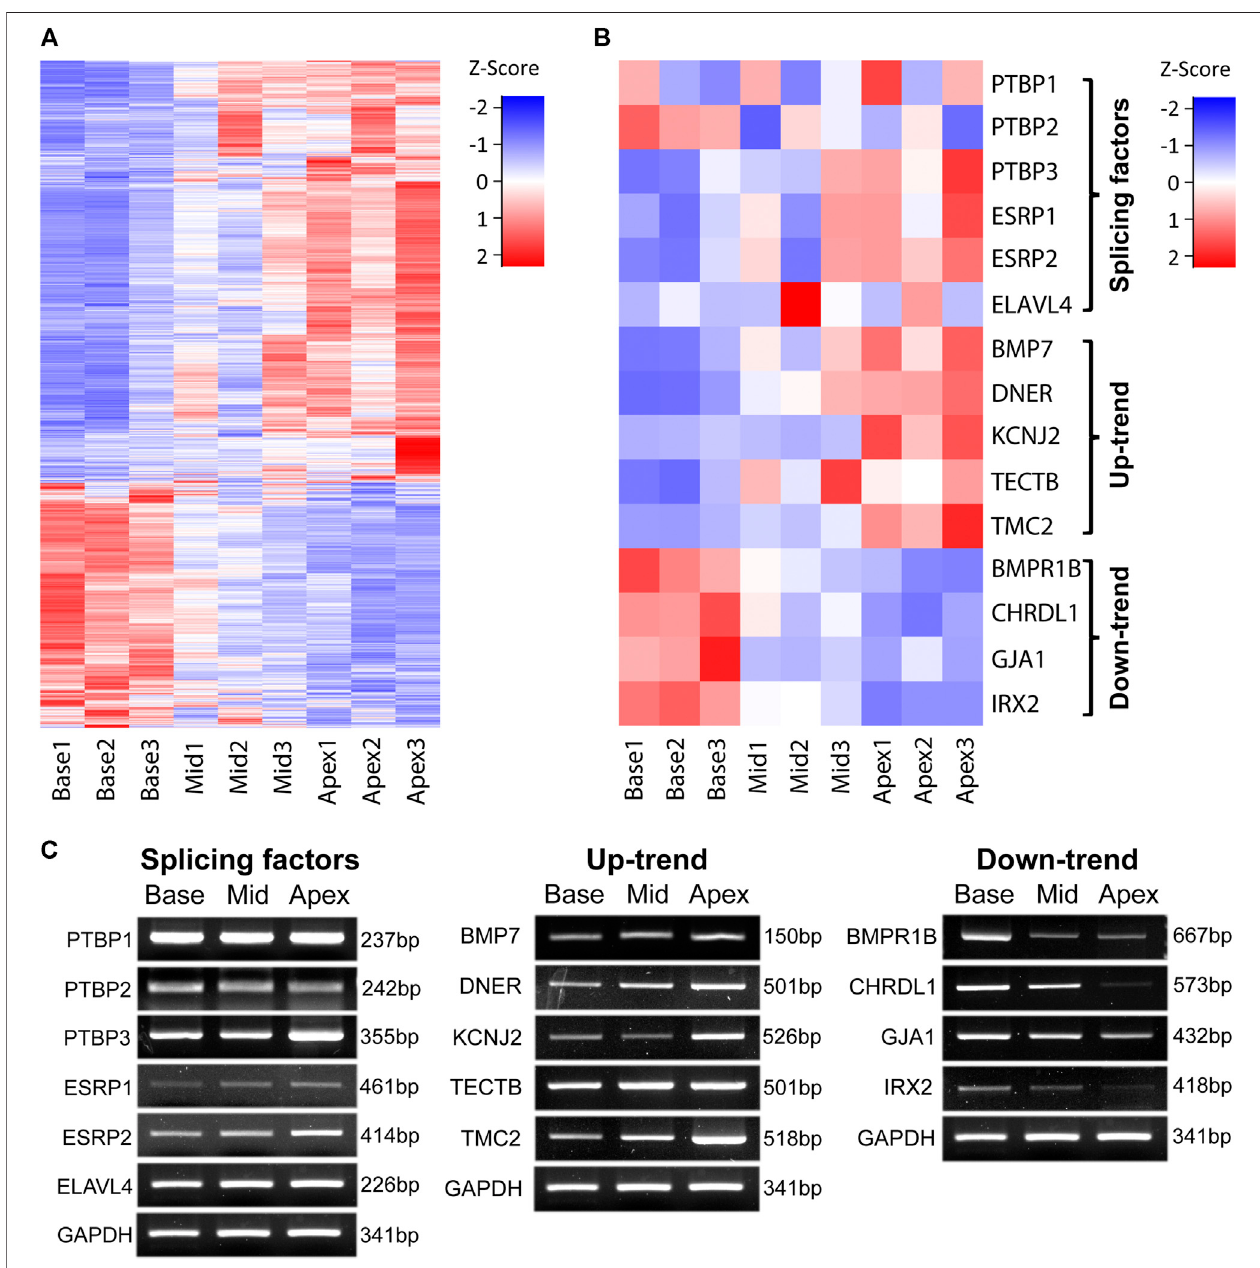
FIGURE2| Expressionpatternsalongthetonotopic axis.Geneexpressionpatternsofgenesalongthetonotopic axisareshown (A) ExpressionpatternsofallUp- trend and Down-trend genes. FPKM values of each gene are used for z-score normalization. (B) Expression patterns of validated genes in three different categories. FPKM values of each gene are used for z-score normalization. (C) RT-PCR images of the selected genes in each category. GAPDH is used as the internal